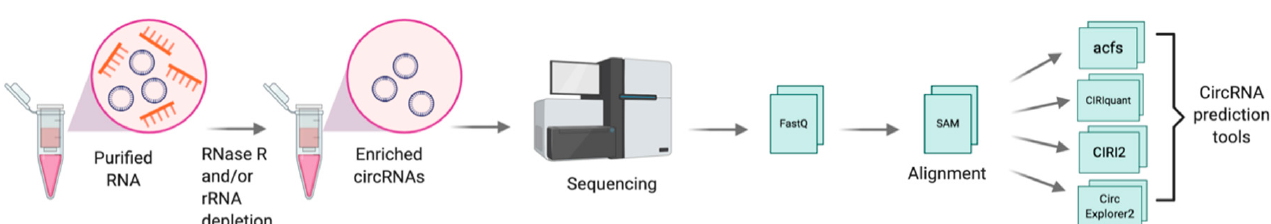
Figure 2. Schematic for discovery of circRNAs through RNA sequencing. Total RNA is isolated and treated with RNase R, in combination with or without depletion of ribosomal RNA (rRNA) and followed by RNA sequencing. Sequenced reads are quality assessed, trimmed and mapped to the human genome. High quality mapped reads are further processed through circRNA prediction tools such as acfs, [33], CIRIquant [34], CIRI2 [35], and CircExplorer2 [36]. Figure created with BioRender.com.